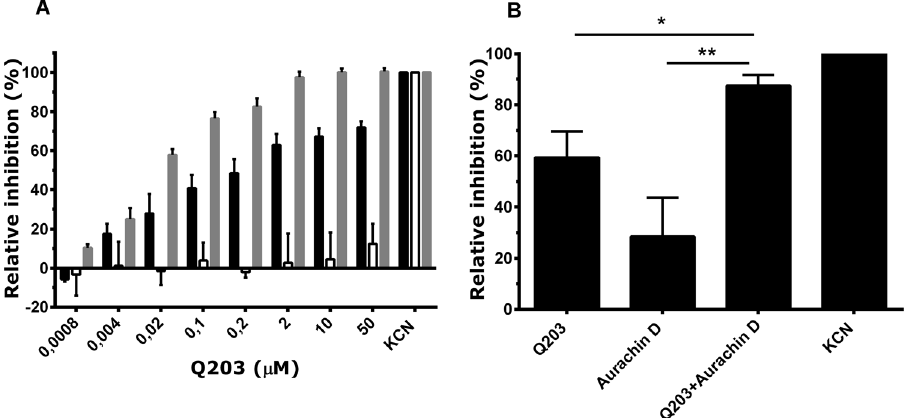
Figure 3. Inhibition of respiratory chain activity of M. smegmatis by Q203 and aurachin D. The oxygen consumption activity of inverted membrane vesicles prepared from M. smegmatis was determined using a Clark-type electrode. ( A ) effect of Q203 on oxygen consumption by M. smegmatis wild-type (black bars) and two mutant M. smegmatis strains lacking either the cytochrome bcc complex 14 (white bars) or cytochrome bd 23 (grey bars). The activities in the absence of inhibitor were 225 nmol O 2 /min/mg protein (wild-type), 250 nmol O 2 /min/mg ( bd -KO) and 145 nmol O 2 /min/mg ( bcc -KO). ( B ) inhibition of oxygen consumption activity of M. smegmatis (wild-type) IMVs by 10 μ M Q203 and 400 nM aurachin D when applied alone or in combination. * and ** represent P < 0.05 and P < 0.01, respectively. Average values were calculated from three independent experiments, error bars represent standard deviations. Potassium cyanide (10 mM) was used as